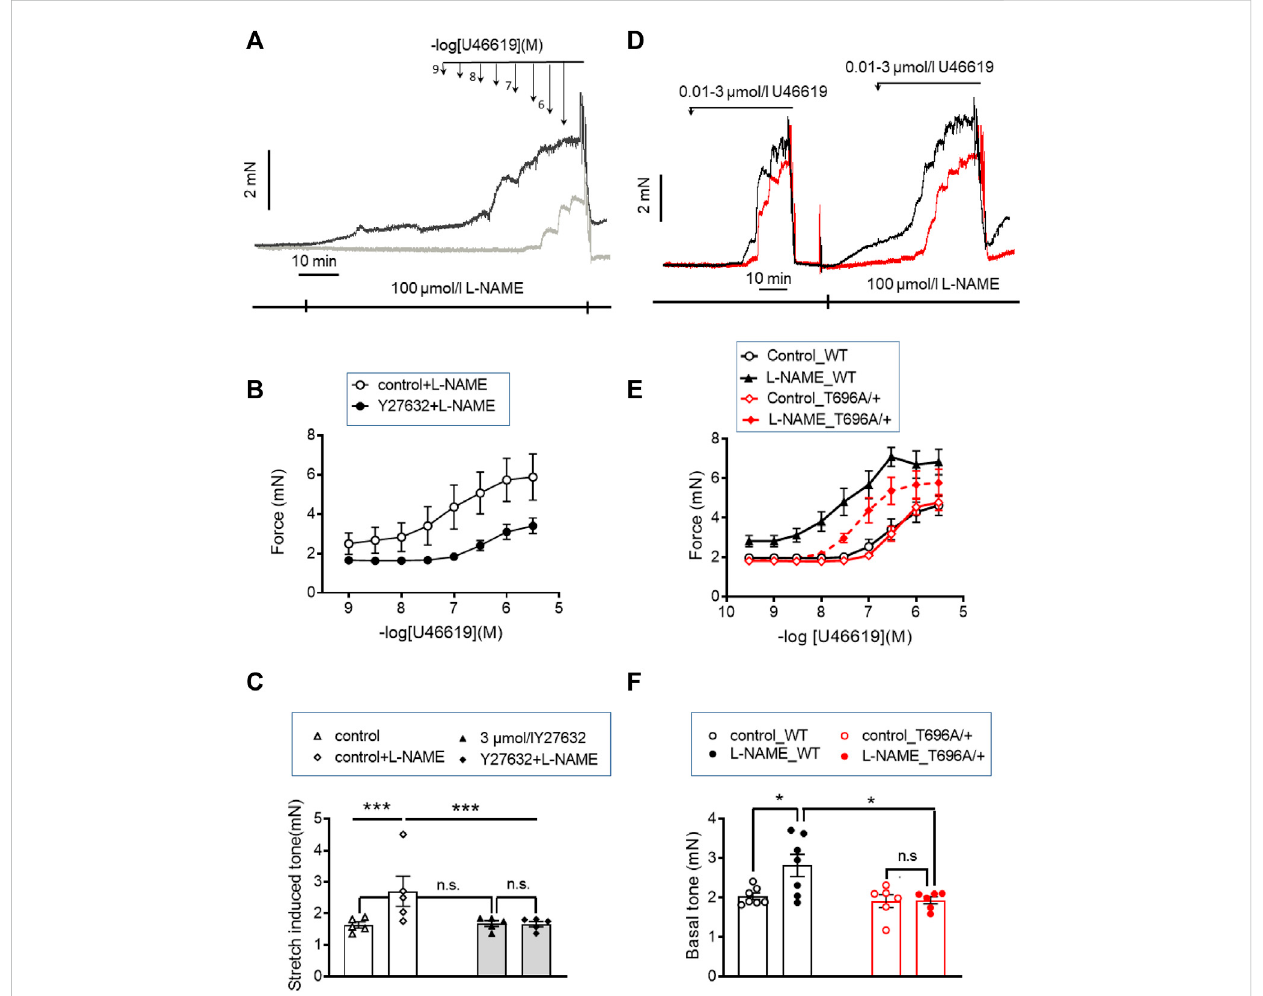
FIGURE 1 Stretch-, L-NAME-, and agonist-inducedforce inyoung murine basilar arteries obtained from WT and MYPT1-T696A/+ -mice. (A – C) Original force tracingsandstatisticalsummaryfrommeasurementofstretch-inducedtonestretch-inducedtoneiny-BAsfromWT-animalstreatedwith100 μ mol/Lof pan-NOS-inhibitor L-NAME in the presence of 3 μ mol/L Y27632 (gray) or vehicle (H 2 O; black). Depicted p -values represent results from 5 independent experiments (*** p < 0.001; n.s. — not signi fi cant, p > 0.05; one way ANOVA n = 5). (D – F) Original force tracings and statistical evaluation of stretch- induced tone, L-NAME- and agonist-induced tone of y-BAs from WT (black) and MYPT1-T696A/+ -mice (red) under control conditions (controls) and after application of 100 μ mol/l L-NAME ( n = 6 – 7; * p < 0.05; unpaired t -test; n.s. — not signi fi cant). Bars represent mean ±